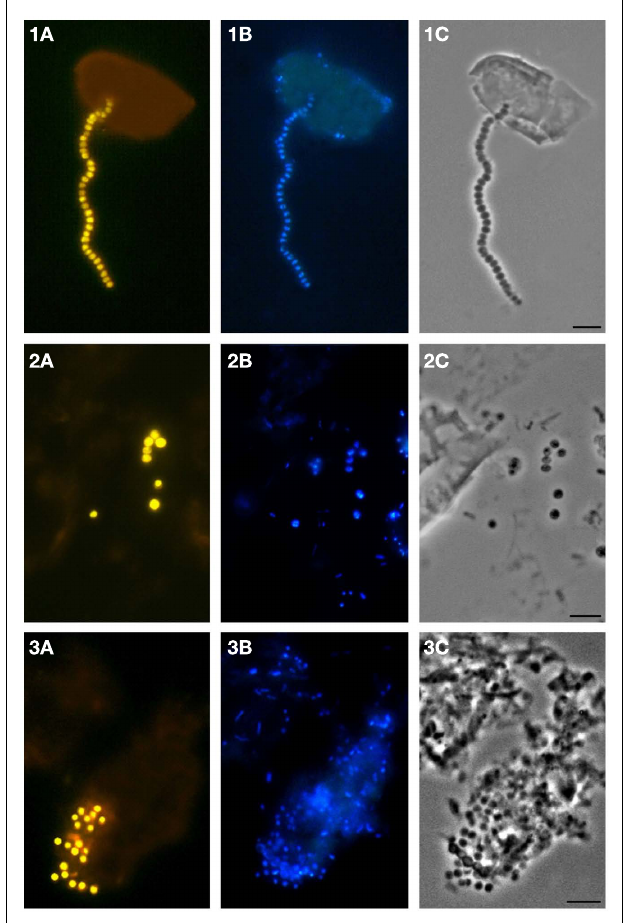
FIGURE 1 | Specific detection of planctomycete cells in Sphagnum peat by FISH. Epifluorescent micrographs of in situ hybridizations with Cy3-labeled probes PLA46 and PLA886 (A) , DAPI staining (B) , and the phase-contrast images (C) are shown. Bar, 10 μ